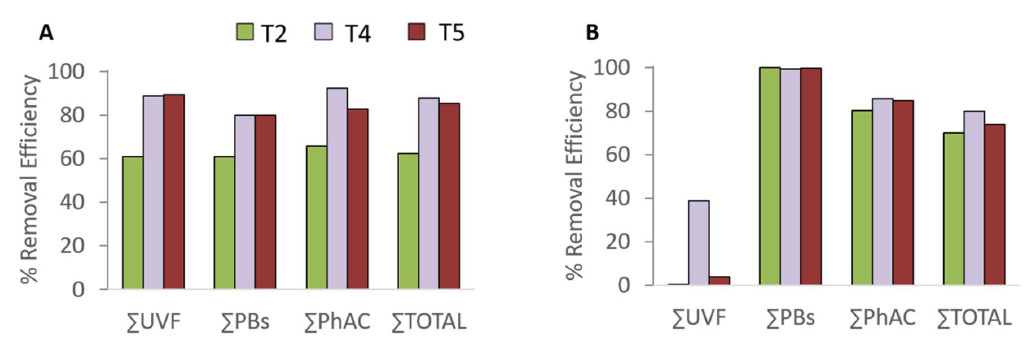
Figure 4. Removal efficiencies for organic UV filters (ΣUVF), paraben preservatives (ΣPB), pharmaceuticals (ΣPhAC), and total CECs (ΣTOTAL) estimated at the effluent of the reference system (T2), the system operating with the reactive barrier based on compost (T4), and the system operating with the barrier based on woodchips (T5) during ( A ) January 2018 and ( B ) March